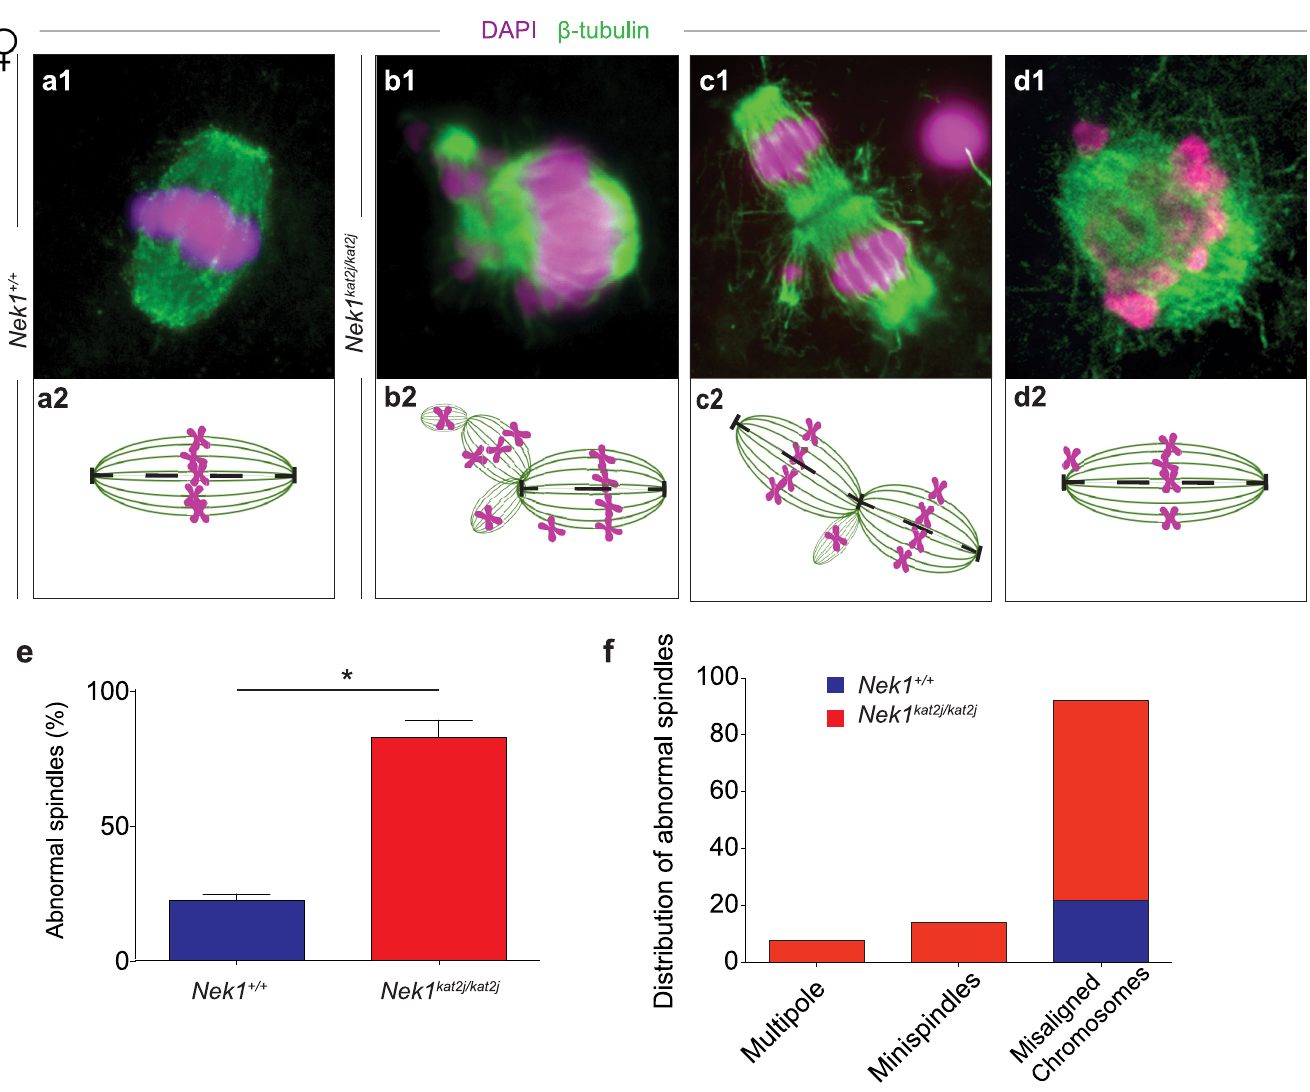
Fig 2. Loss of NEK1 results in disrupted spindle morphology and chromosome congression during meiosis I in oocytes. (a-d) Immunofluorescence (IF) against β -tubulin(green) and DNA stainingwith DAPI (magenta) showingmeiotic spindlemorphology(panels a1-d1), with graphicrepresentations below (panelsa2-d2). (a) Nek1 +/+ oocyte shows normalspindlemorphology and chromosome congression at the midplateof the spindle;(b-d) Examplesof aberrantspindlemorphology in oocytes from Nek1 kat2j/kat2j mice showingmultipolarspindleswith or without errors in chromosome congression (arrowheads indicate three extra spindlesformed in the oocyte in b and two additionalspindlesin c). (e) Quantitationof abnormal spindlesin oocytes from Nek1 +/+ and Nek1 kat2j/kat2j mice (n = 100 cells countedfor each). (f) Quantitation of cells with abnormal spindlesby type of defect. Valuesare percentages ± Standarddeviation. * Indicates statistically significantdifferences(Unpairedt-test p < 0.05).